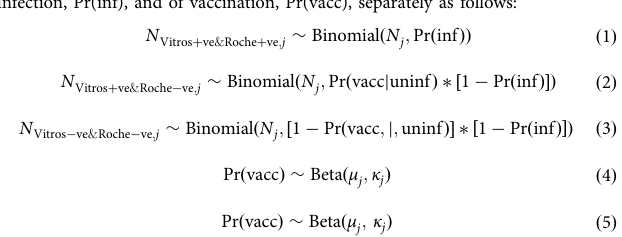
two weeks. Institutional policy requires the use of a data sharing contract for sharing clinical